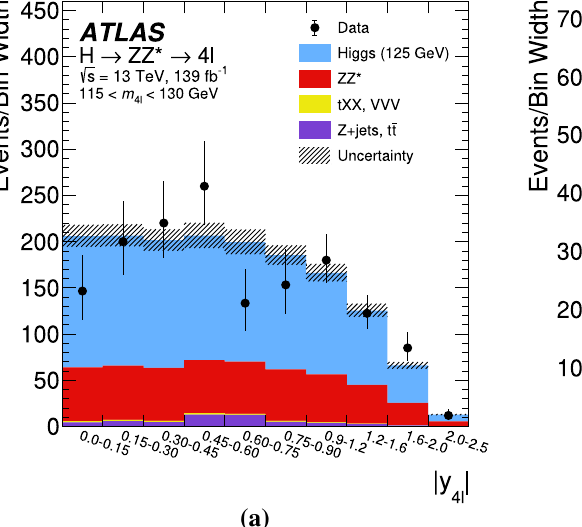
Fig. 5 The observed and expected (pre-fit) distributions of a | y 4 (cid:3) | and prediction is shown by the hatched band, which includes the theoret- b | cos θ ∗ | in the mass region 115 < m 4 (cid:3) < 130 GeV, for an integrated ical uncertainties of the SM cross section for the signal and the Z Z ∗ √ luminosity of 139 fb − 1 collected at s = 13 TeV. A SM Higgs boson signal with a mass m H = 125 GeV is assumed. The uncertainty in the